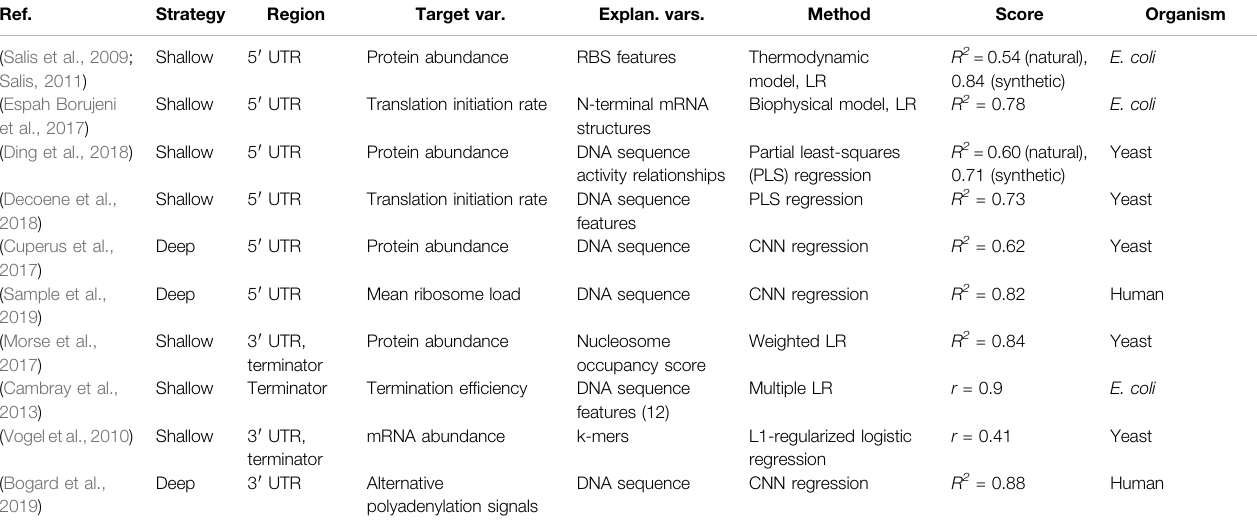
TABLE 2 | ( Continued ) Overview of studies modeling gene expression-related properties from separate regulatory or coding regions. Highest achieved or average scores are reported, on test sets where applicable, and include accuracy ( acc ), area under the receiver operating characteristic curve (AUC), area under the precision recall curve (AUPRC), the coef fi cient of variation ( R 2 ) and Pearson ’ s correlation coef fi cient ( r ).